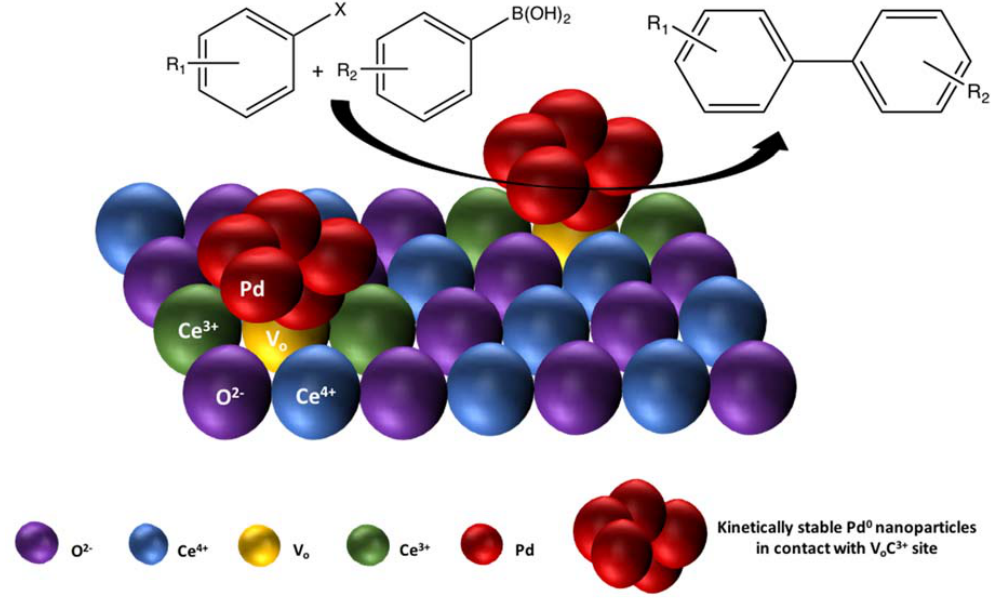
Figure 5. Plausible heterogeneous catalytic reaction mechanism suggested for Suzuki cross-coupling over the Pd/CeZrO 4 ‐δ redox catalyst [43] (Adapted with permission from John Wiley and Sons).